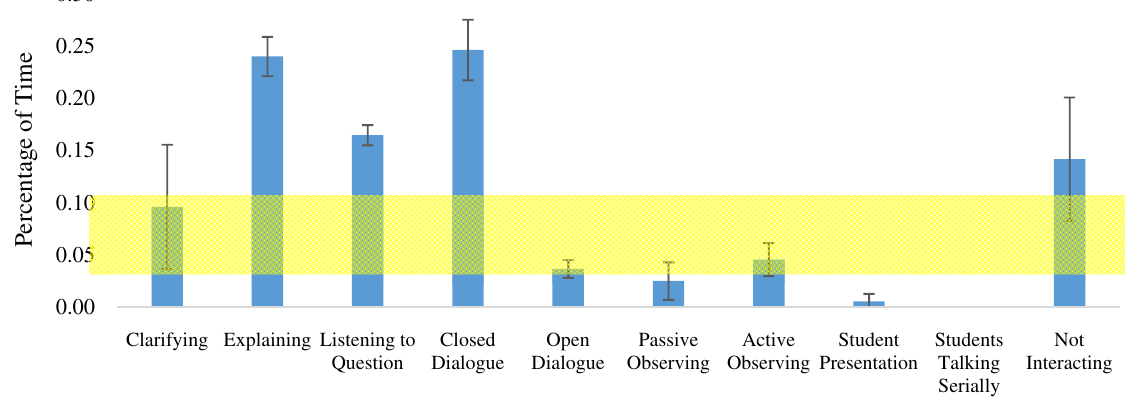
FIG. 3. The RIOT profile for a single TA. Data which fall below the shaded area are categorized as “ relatively low. ” Data above the shaded area are categorized as “ relatively high. ” Data within the shaded area are categorized as “ medium. ” For this TA, there was no occurrence of the Students Talking Serially code, so it would be categorized as “ none. ”